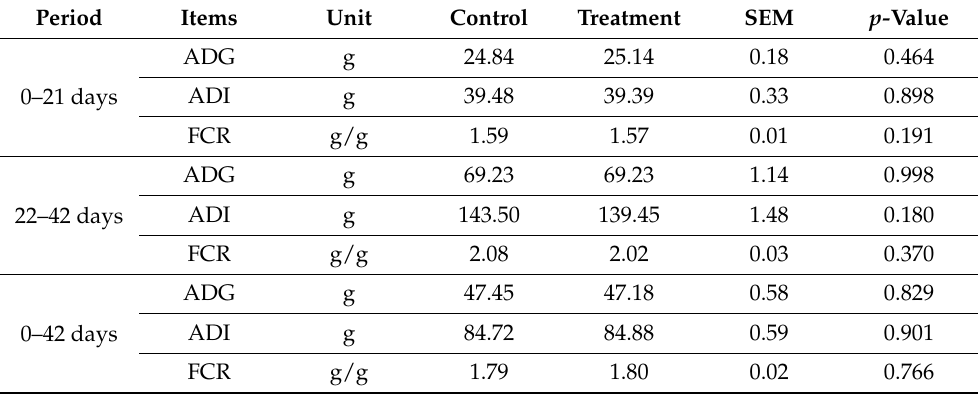
Table 2. Effects of lecithin on the performance and mortality of broilers throughout the experiment 1 . Period